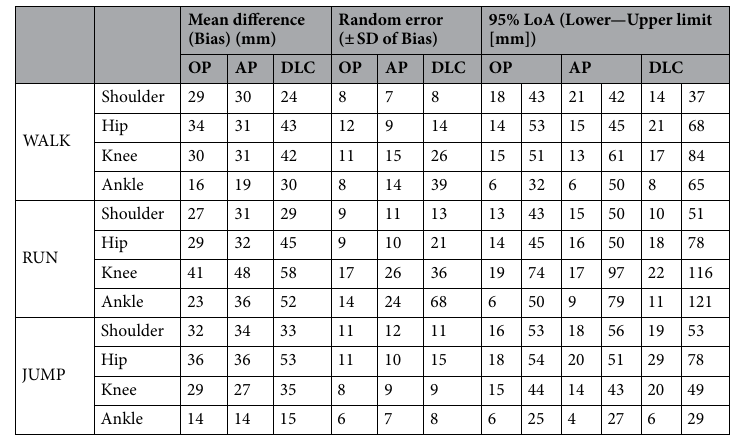
Table 1. Bland–Altman analysis results of 3D Euclidean differences during walking, running and jumping. OP = OpenPose, AP = AlphaPose, DLC = DeepLabCut.